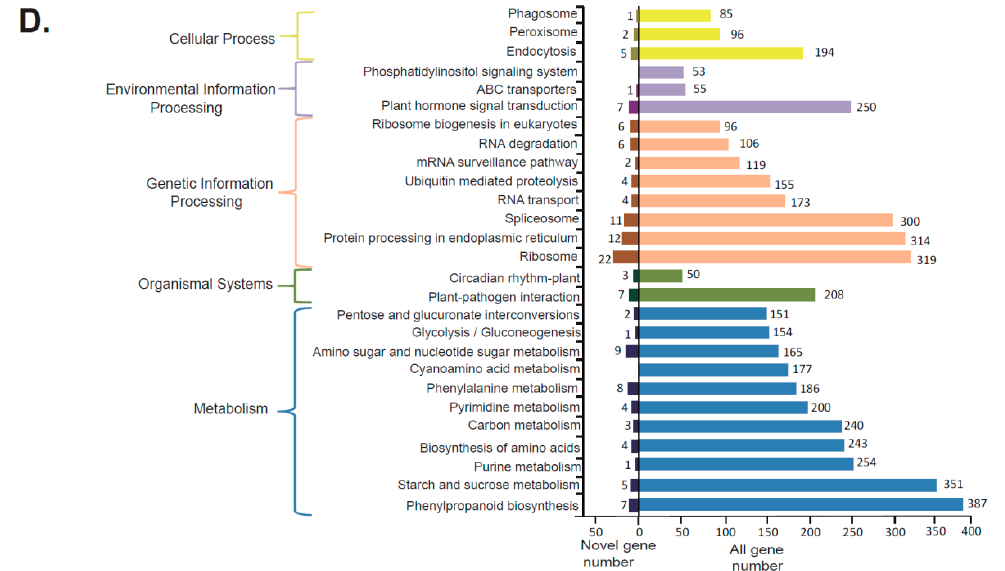
Figure 3. ( A ) All gene and novel gene annotation by the searching of seven databases; ( B ) NR (NCBI nonredundant protein sequences) homologous species distribution diagram of all genes and novel genes; ( C ) Distribution of GO (Gene Ontology) terms for all annotated genes and novel genes, cellular component and molecular function; ( D ) KEGG (Kyoto Encyclopedia of Genes and Genomes) pathways of all genes and novel genes involved in cellular process, environmental information processing, genetic information processing, organism systems, and metabolism.